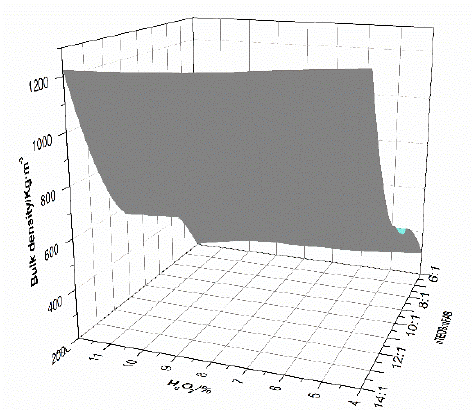
Figure 2. Three-dimensional graph of the influence of H 2 O 2 and TEOS content on bulk density (FAS content was fixed at 1% of MgO mass).